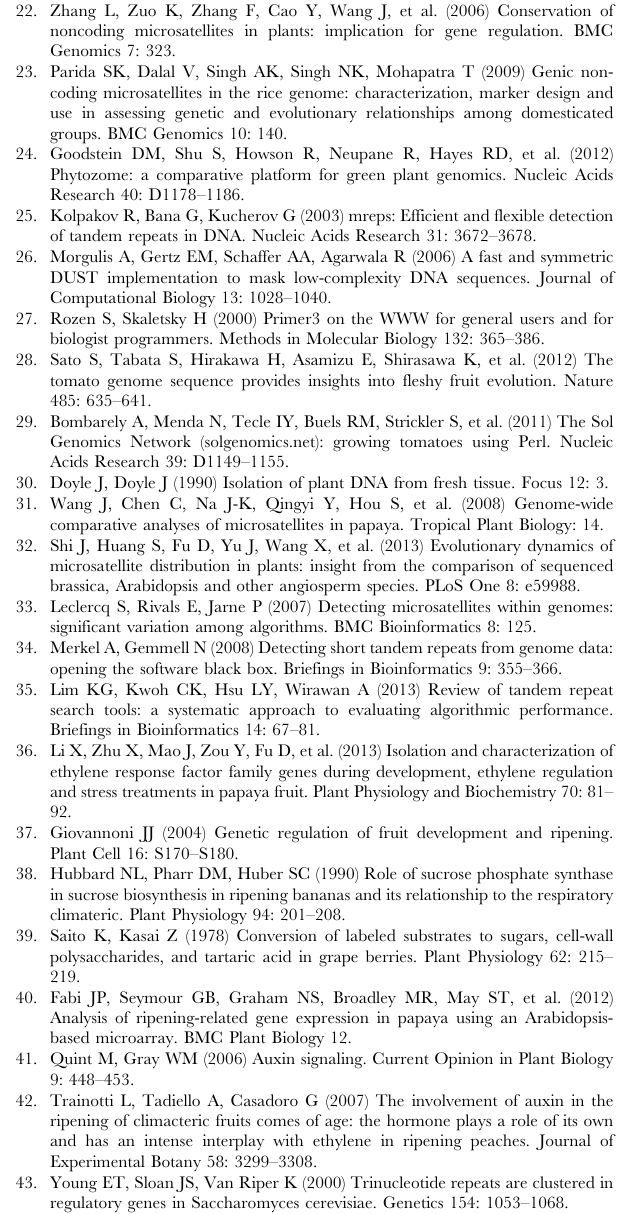
Table S3 Class I SSR markers. Table S4 Distribution of SSR motifs by linkage group. Table S5 Distribution of SSR types by linkage group. (XLS) Table S6 Number of successfully designed primer pairs for each SSR type, genomic location and linkage group. Table S7 SSR markers for cell wall genes.